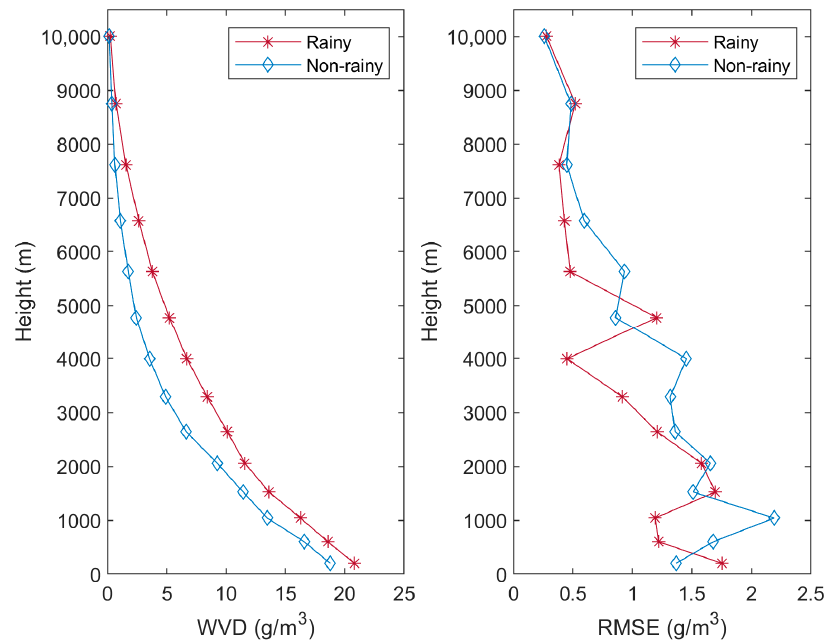
Figure 5. WVD ( left ) and RMSE ( right ) of the refined tomographic model during rainy (red) and non-rainy (blue) phases.